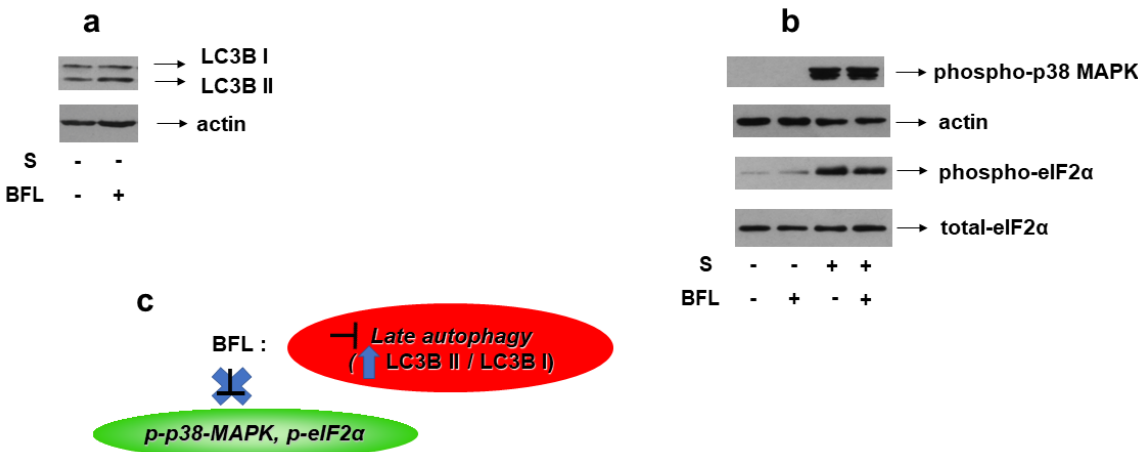
Figure 13. Effect of autophagy inhibition on hyperosmotic-stress-induced responses in H9c2 cells. H9c2 cells were left untreated or were incubated with bafilomycin (BFL) alone, or with BFL followed by exposure to 0.5 M sorbitol in the presence of BFL. Cell extracts (40 μ g/lane) were subjected to SDS-PAGE and immunoblotted with antibodies against endogenous levels of total LC3B protein (LC3 I and LC3 II forms) (( a ) upper panel), phosphorylated p38-MAPK (( b ) upper panel), phosphorylated eIF2 α (( b ) 3rd panel from top), total levels of eIF2 α (( b ) bottom panel). Equal protein loading was verified by immunoblotting identical samples with a specific anti-actin antibody (( a ) bottom panel and ( b ) 2nd panel from top). Western blots are representative of at least three independent experiments with overlapping results. ( c ): Schematic representation of the effect of late autophagy inhibition by bafilomycin under hyperosmotic stress conditions: BFL (which is a late autophagy inhibitor evidenced by upregulation of the LC3B II/LC3B I ratio) does not modify the phosphorylation status of p38-MAPK or eIF2 α .